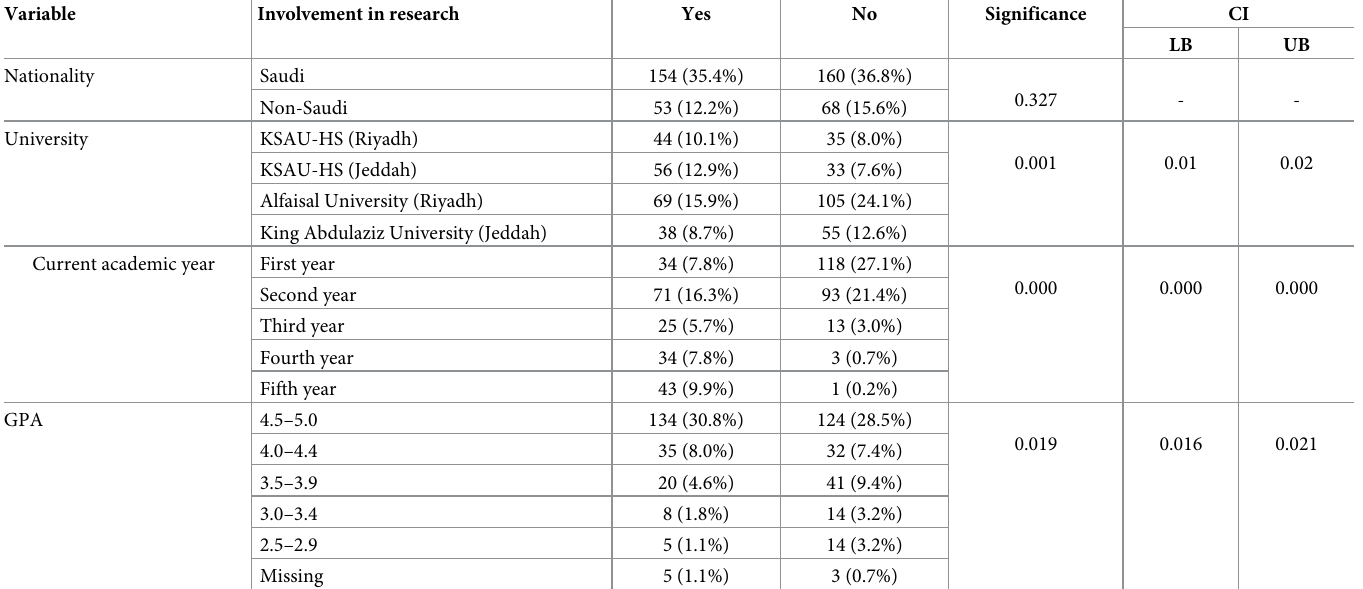
Table 2. Involvement in research vs participants’ characteristics.